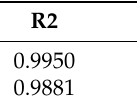
Table 2. Comparison of soft-sensing model in the test set.